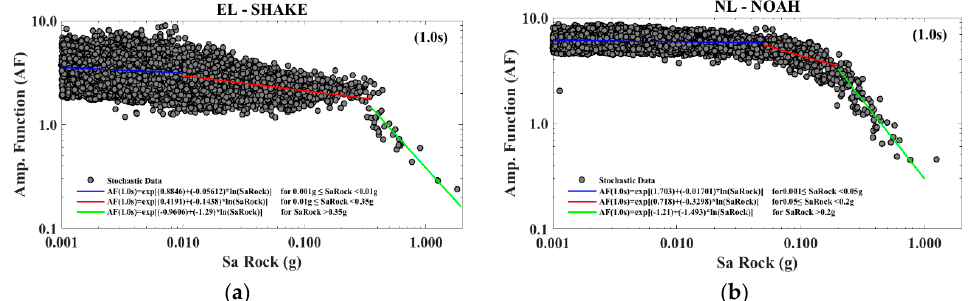
Figure 15. Trilinear piecewise regression models of AF ( f ) on S r a ( f ) for three different spectral periods (PGA, 0.2 s, 1.0 s): ( a ) Figures built using the accelerograms propagated with EL-SHAKE91. ( b ) Regression on the accelerograms propagated with NL-NOAH. The regression coefficients are indicated inside each plot (for each linear segment), see Table 3.